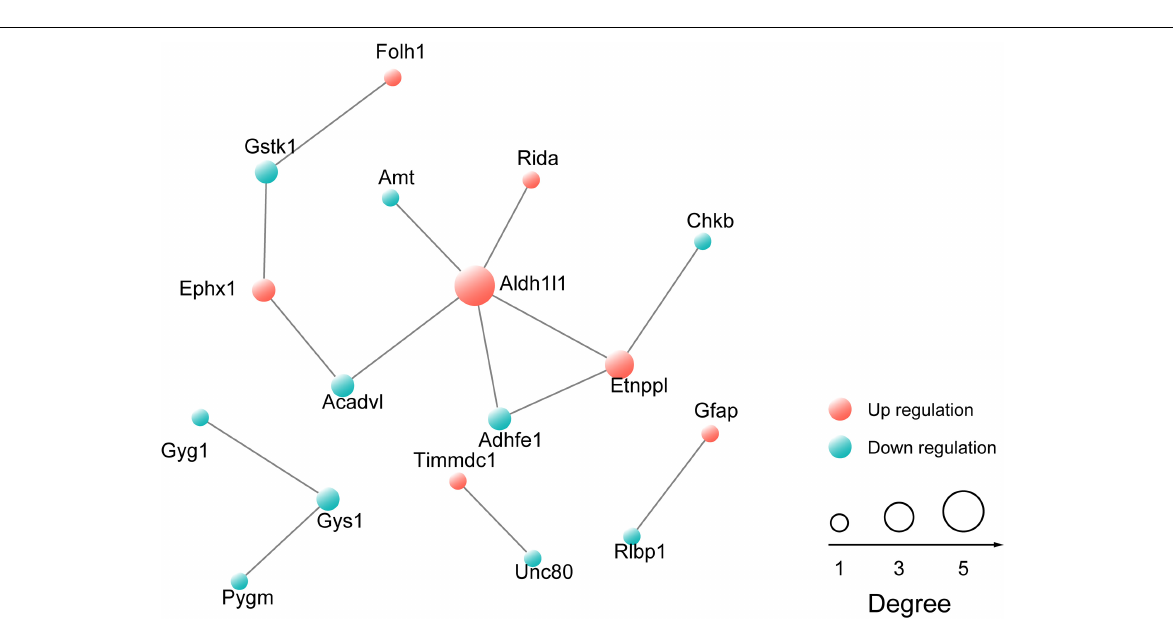
Frontiers in Molecular Neuroscience |